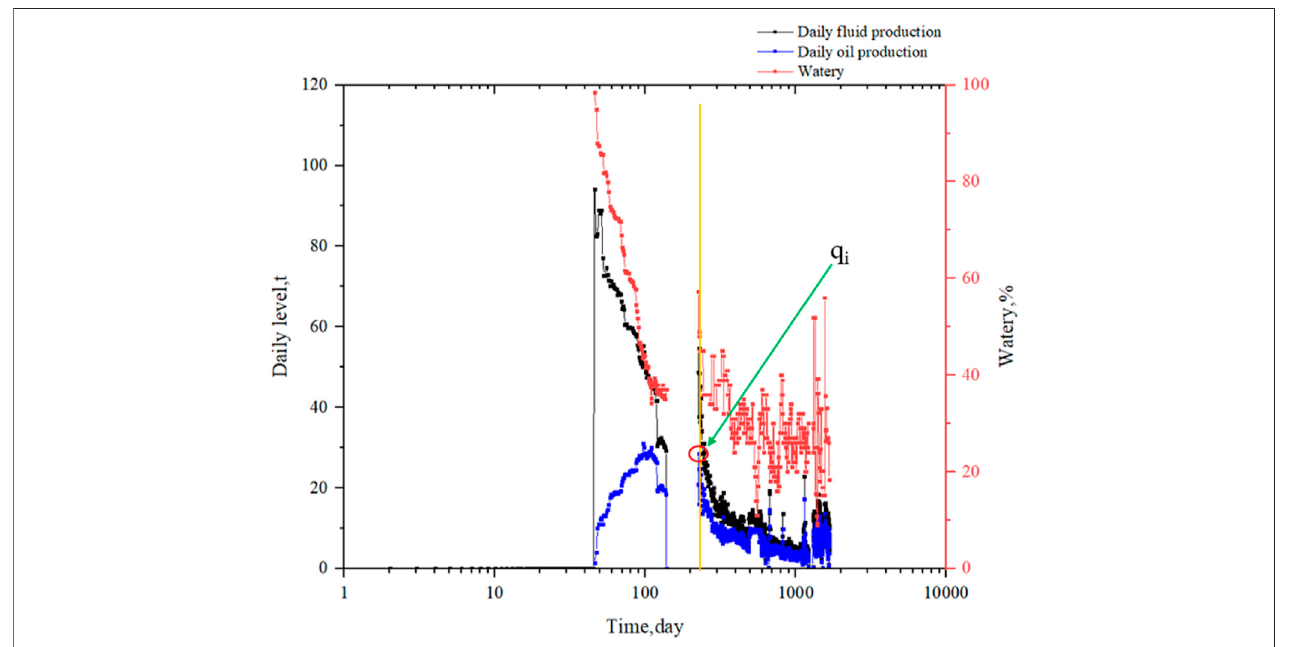
FIGURE 8 | Production performance curve of Well JI36_H.